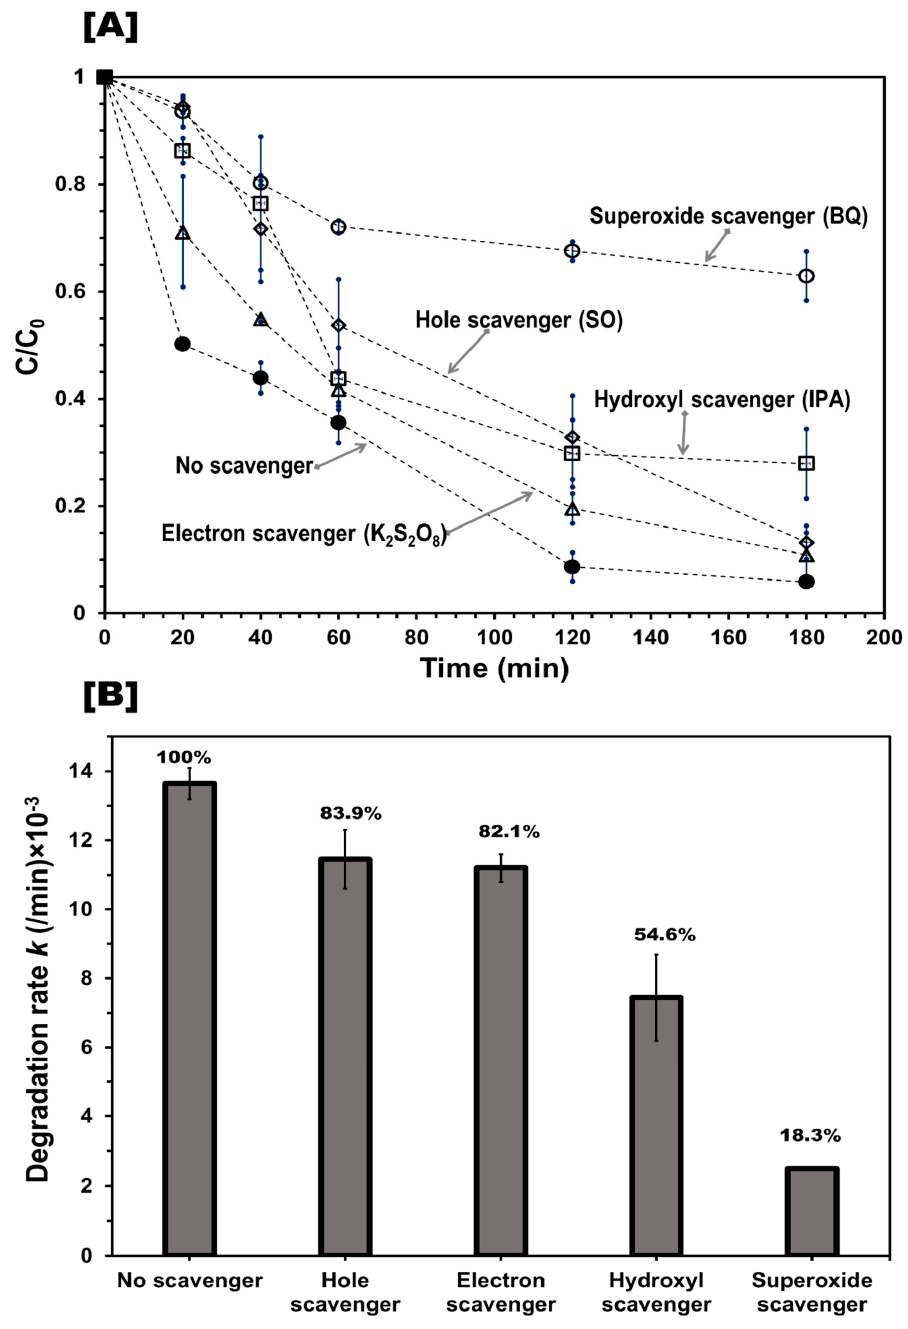
Figure 7. Effects of the absence and presence of scavengers on ( A ) the photodegradation efficiency and ( B ) the degradation rate of CBZ over UiO-66_GO-0.5. (Experimental conditions: initial CBZ concentration = 5 mg/L; solution pH 7; concentration of UiO-66_GO-0.5 = 1 g/L; solution volume V = 50 mL). Plots and error bars represent averages and standard deviations from duplicate experiments.